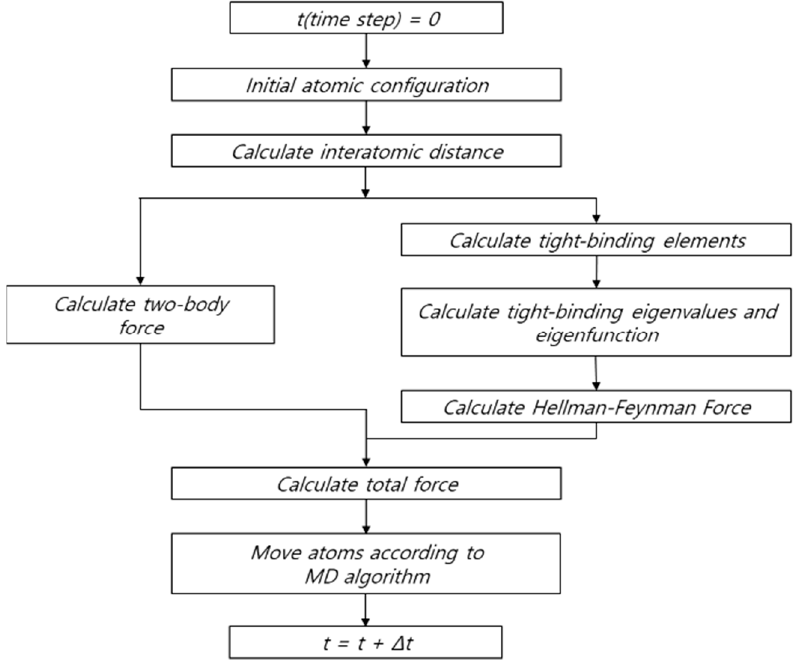
Scheme 1. Flow chart of the tight-binding molecular dynamics calculations.